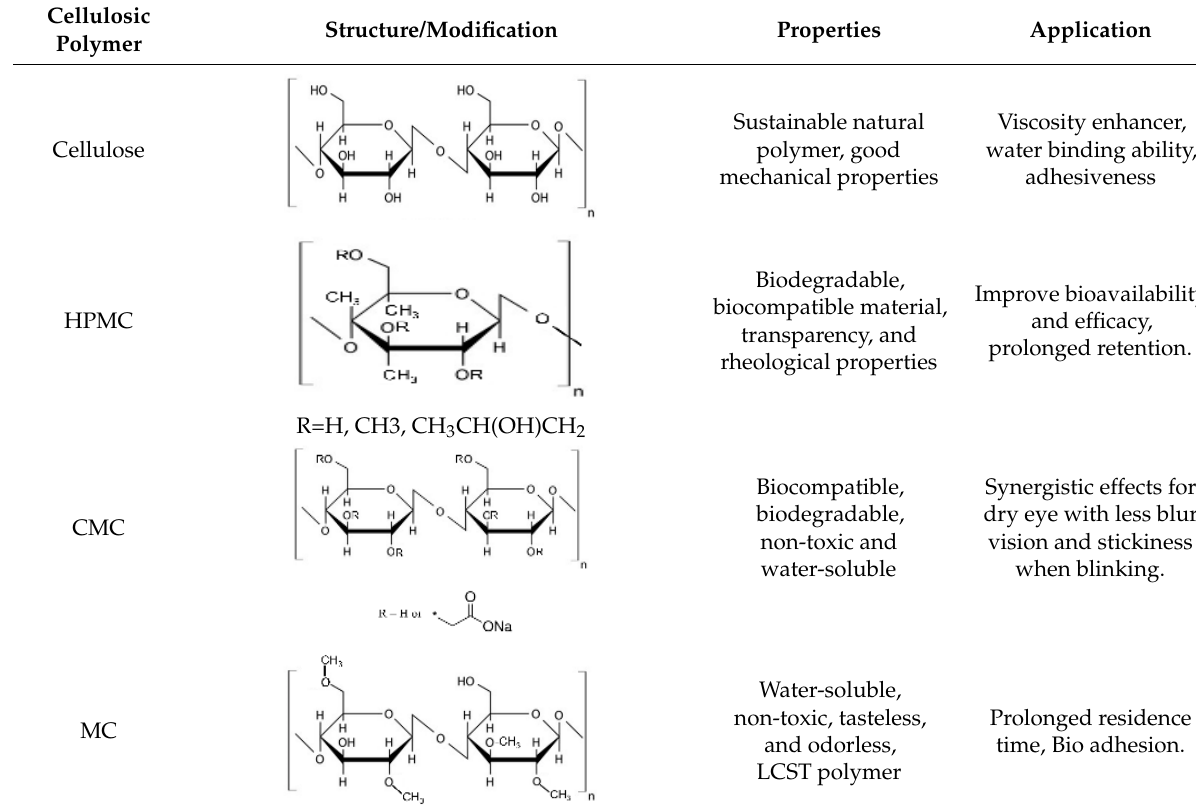
Table 1. Cellulosic polymer structure, properties, and application.